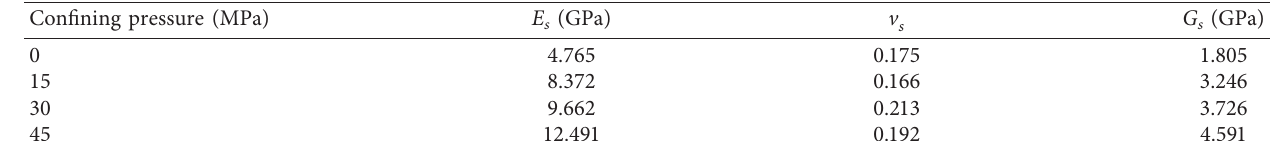
Table 7: The three independent parameters of the tight sandstone samples.